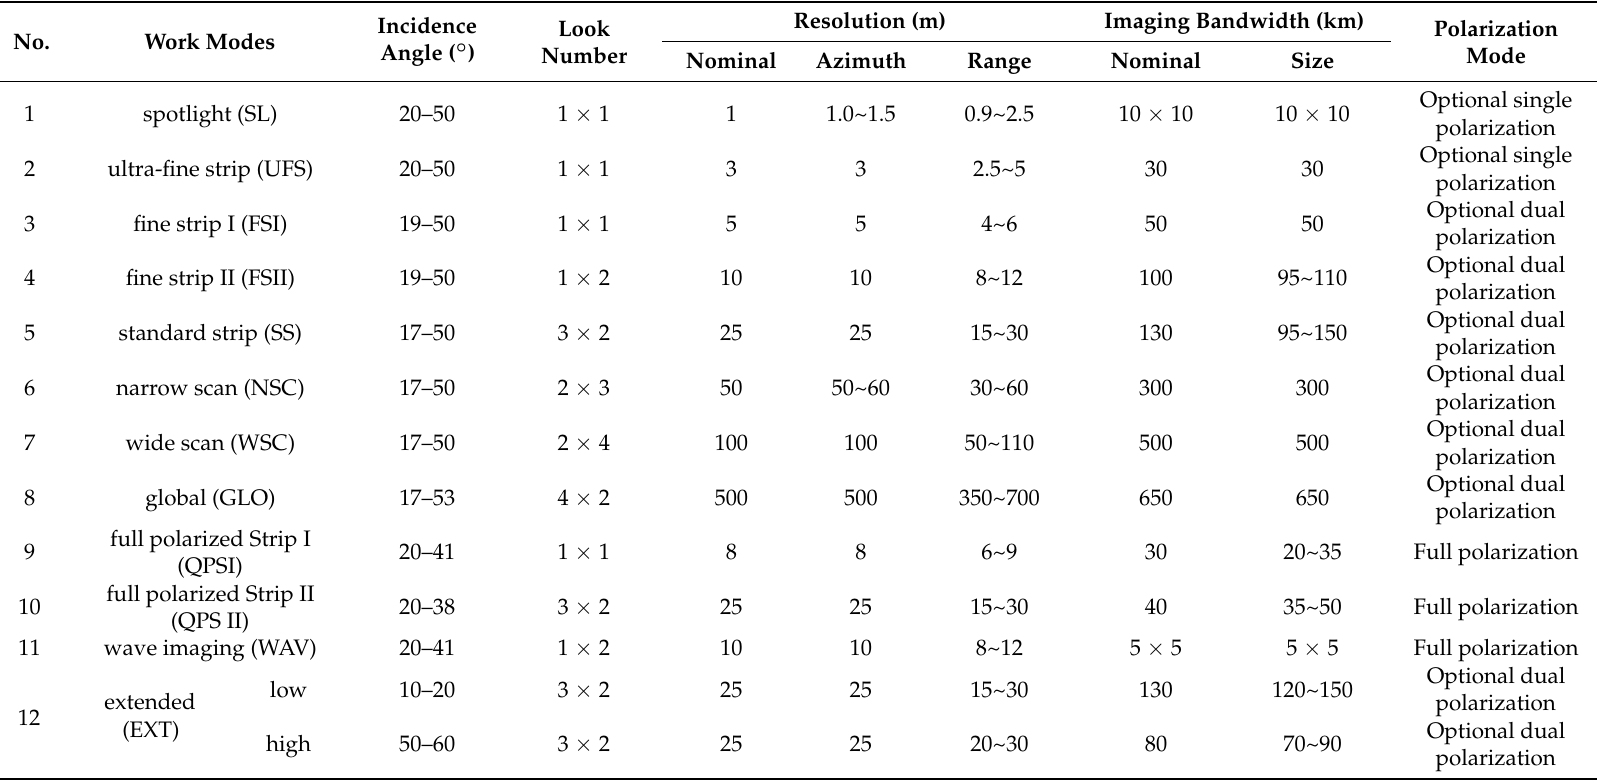
Table 1. Observation patterns of the GF-3